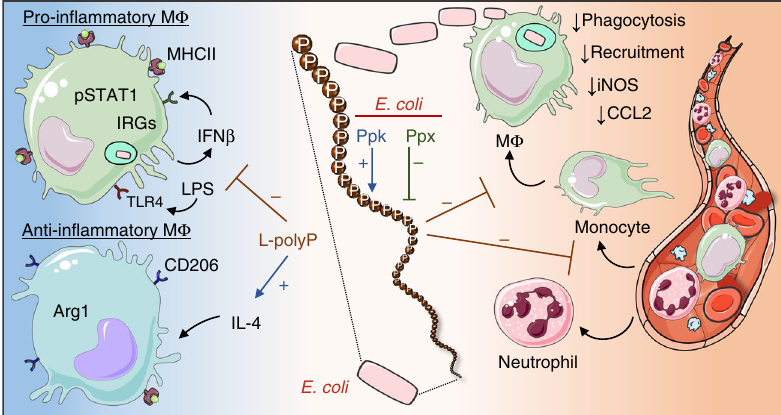
Fig. 6 Schematic of polyphosphate effects on myeloid cells. Long-chain polyphosphate (L-polyP) generation in E. coli is balanced by polyphosphatekinase (Ppk) and exopolyphosphatase (Ppx). Polyphosphates inhibit ( − ) the local recruitment of monocytes to the site of infection and their maturation into bactericidal macrophages (M Φ ) including suppression of inducible nitric oxide synthase (iNOS). The polyphosphates further reduce an effective clearance of bacteria by counteracting phagocytosis in macrophages, monocytes and neutrophils. The LPS/TLR4-induced polarization of macrophages into the proin fl ammatory type ( “ M1 ” ) is opposed by polyphosphates. In addition, polyphosphates antagonize the production and response to IFN β , interferon- regulated genes (IRGs), MHCII and STAT1 signaling. Simultaneously, long-chain polyphosphates enhance ( + ) the expression of some anti-in fl ammatory markers ( “ M2 ”